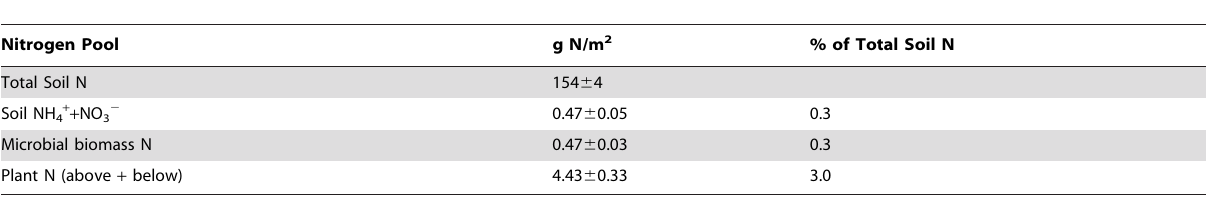
Table 1. Soil (0–10 cm), microbial, and plant N pools.